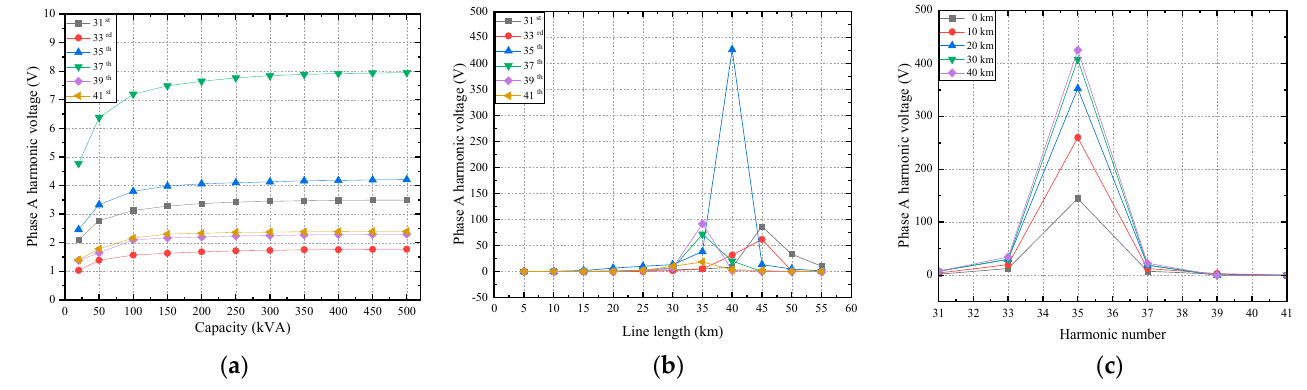
Figure 7. Phase A harmonic voltage simulation: ( a ) different transformer capacity used; ( b ) different line lengths; ( c ) the locomotive is in different positions on the line.